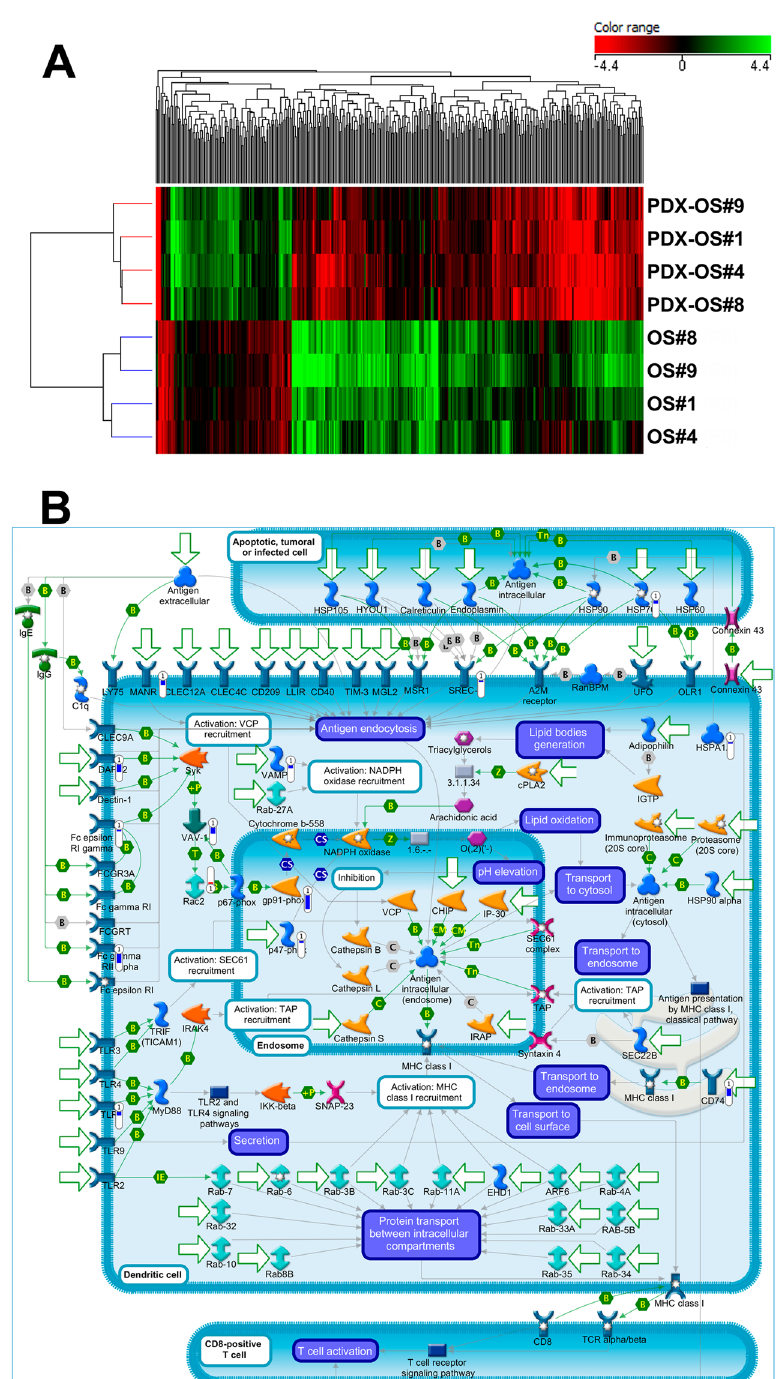
Figure 3. ( A ) Heatmap of OS samples obtained using the list of 397 genes (see Supplementary Table 3) that are differentially expressed (adjusted p < 0.05) between primary tumors and PDX. Genes (columns) and samples (rows) were grouped by hierarchical clustering (Manhattan correlation). High- and low- expression is normalized to the average expression across all samples. ( B ) Map of “Immune response_Antigen presentation by MHC class I” pathway, which is the top scored (lowest p value) ma p based on Genego pathway enrichment analysis. Experimental data (OS PDX/primary tumor ratio) from microarray experiments are visualized on the map as thermometer-like figures. Significantly upregulated genes show upward, red bars, while down-regulated genes show downward, blue